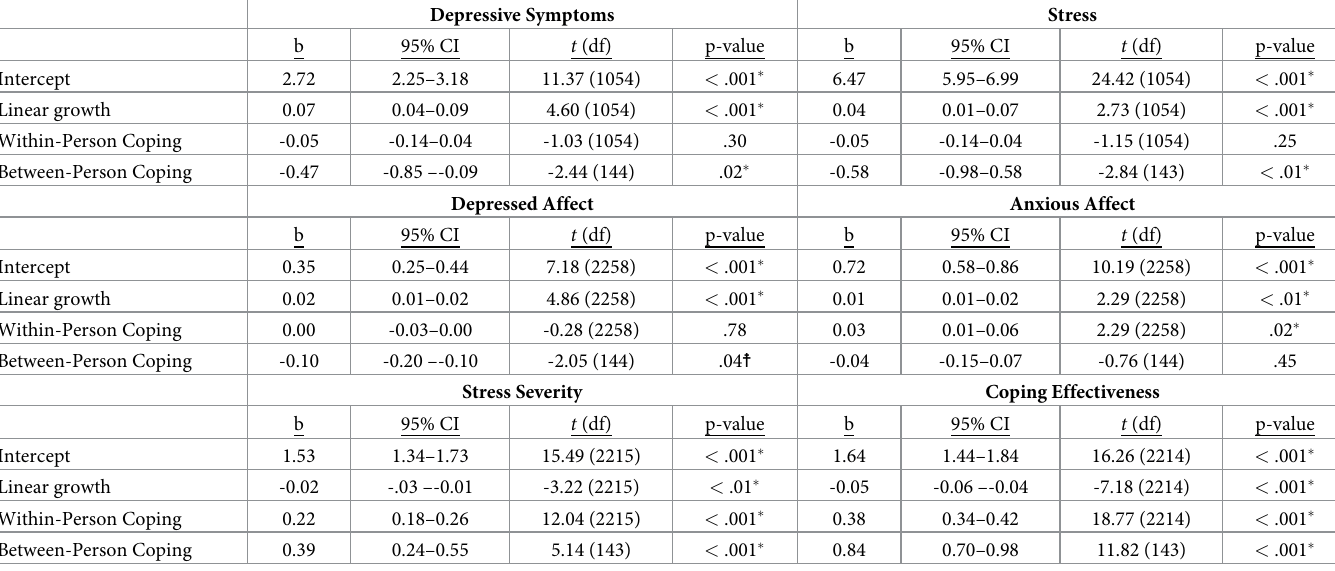
Table 2. Psychosocial outcomes predicted by coping strategies.